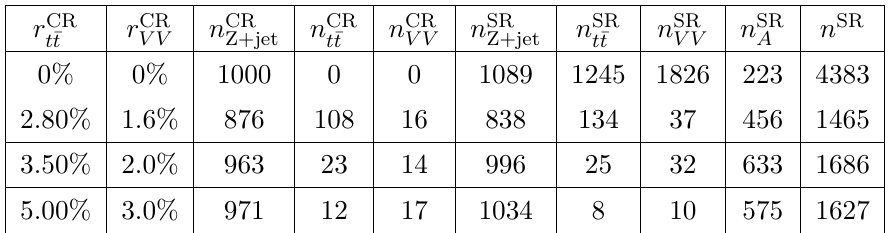
Table 5 . Number of events selected by the classifier from the different classes in the signal and control region for different compositions of the control region. There is a fixed fraction of anomalous events ( f SR = 0 . 01 ) and we have r SR = 3 . 5% and r SR = 2% V V t ¯ t